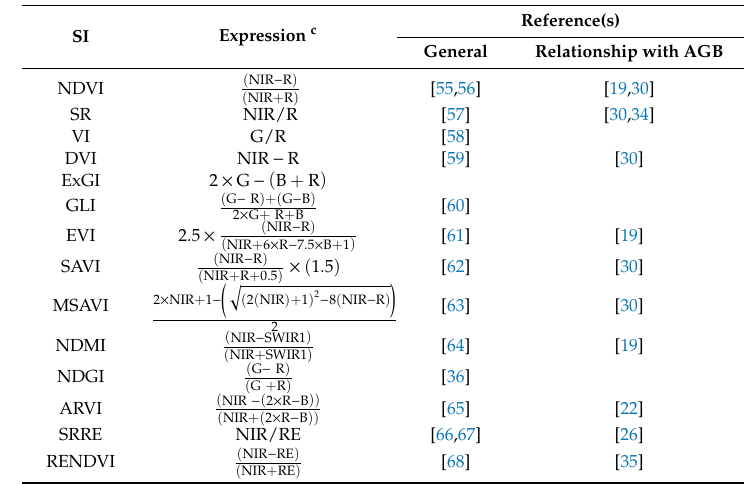
Table 2. Description of spectral indices (SIs) used as candidate independent variables for aboveground biomass (AGB) modelling in this research.